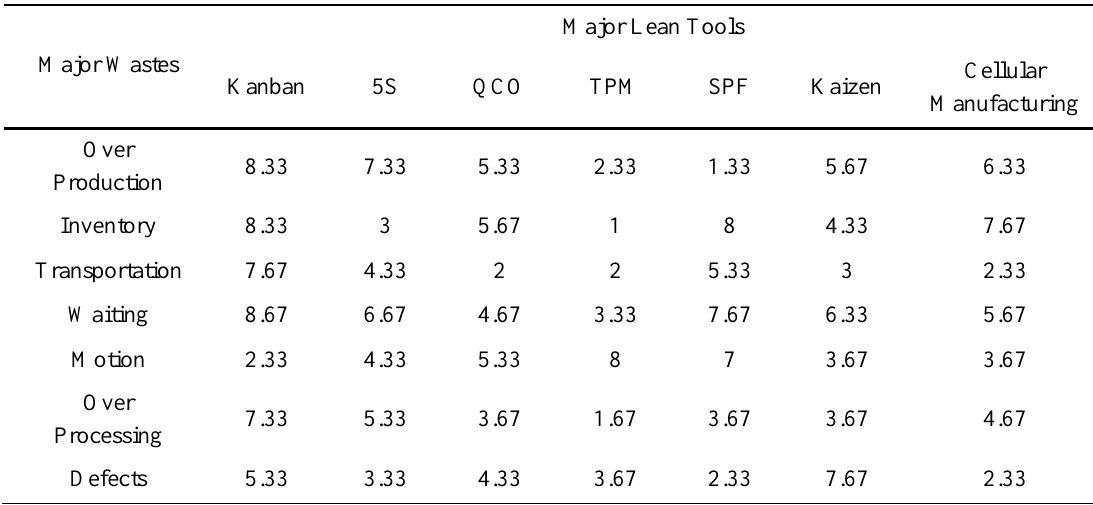
Table 2. Decision matrix for TOPSIS